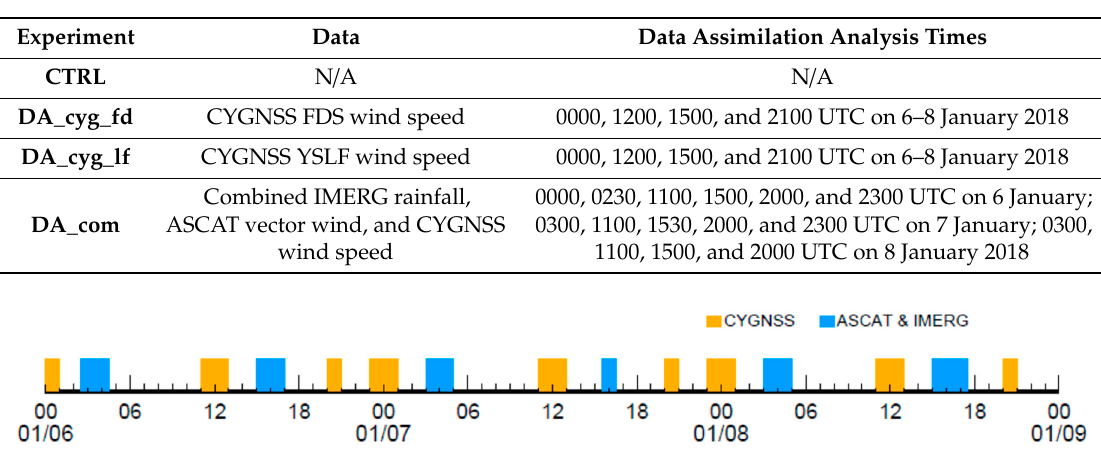
Table 1. Numerical Experiments setup.